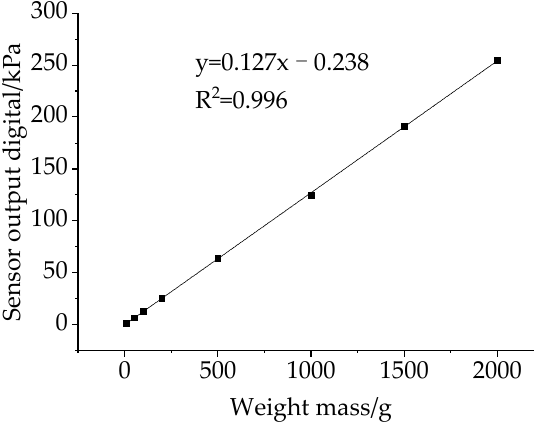
Figure 8. Calibration curve of expansion pressure detection unit.